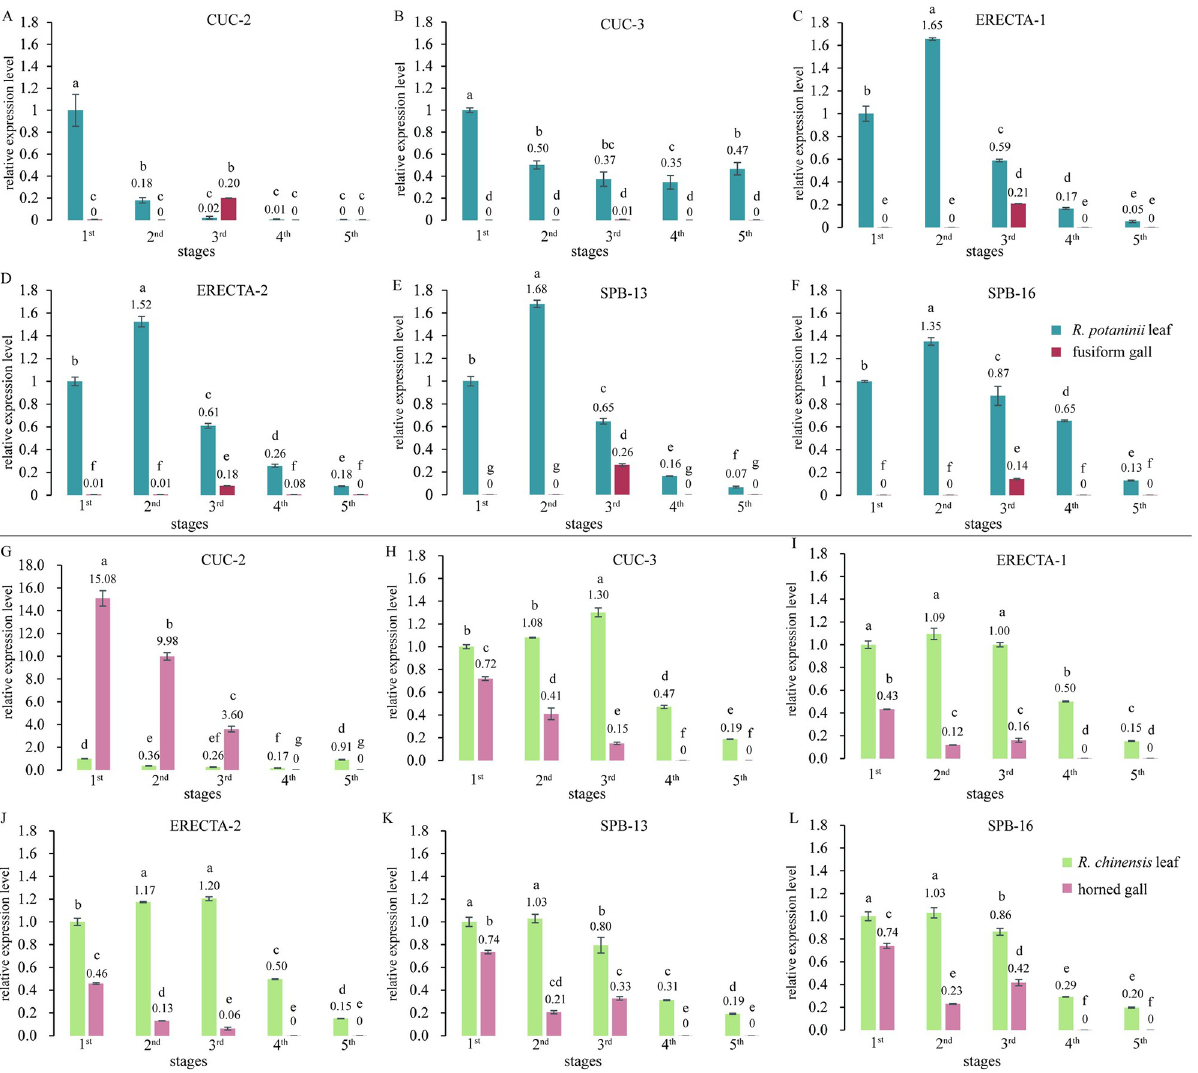
Fig 7. qRT-PCR analysis of genes regulating serration development at different stages. (A-F) Relative expression levels of candidate genes in R . potaninii leaflets and fusiform galls. (G-L) Relative expression levels of candidate genes in R . chinensis leaflets and horned galls. Gene expression levels were high in R . potaninii and R . chinensis leaflets and low in fusiform galls that did not possess horns; gene expression levels in R . chinensis leaflets and horned galls were high in first, second, and third stages. Lowercase letters indicate significant differences among five stages of each gene in gall and host plant, with average values decreasing from a to g, and no significant difference if they have the same letter. P < 0.05.